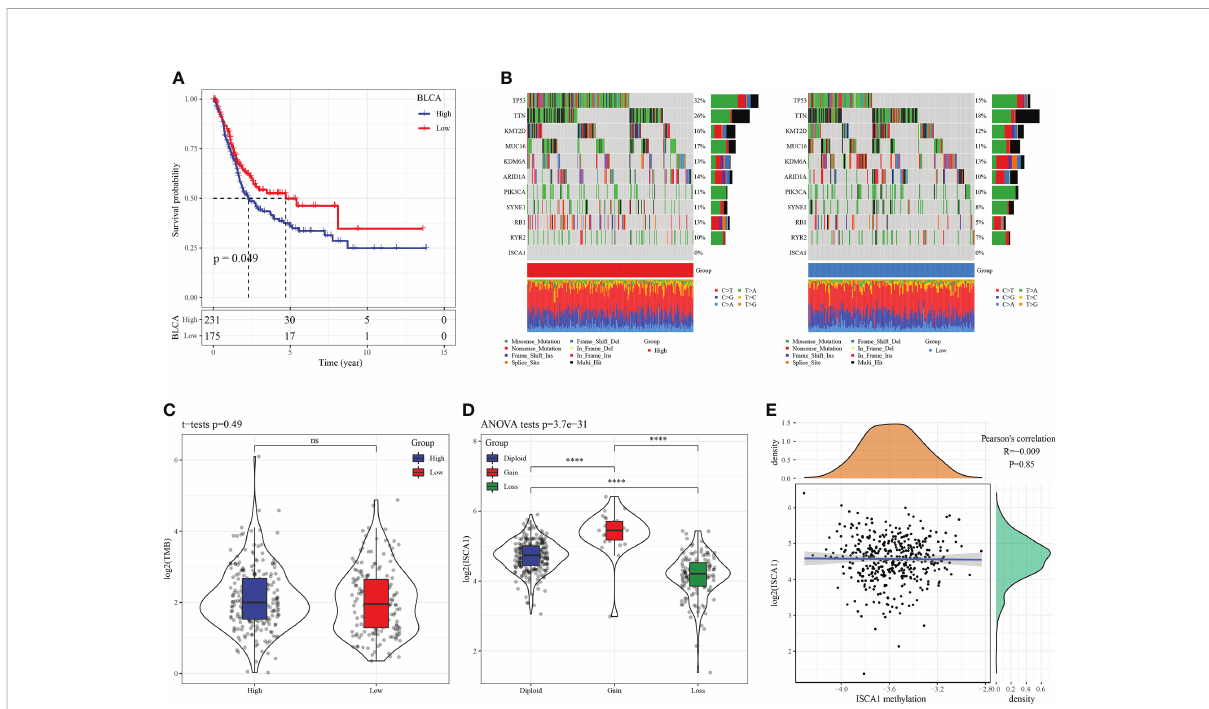
FIGURE 3 SNV, CNV, and methylation analysis in BLCA. (A) : In BLCA, the KM curve showed that patients in high ISCA1 group had worse survival outcome compare to low ISCA1 group, both of which were borderline signi fi cant; (B) : The mutation distribution of the top 10 genes with the highest frequency of mutations in the high ISCA1 expression group and low ISCA1 expression group; (C) : The distribution of TMB in high ISCA1 expression groups and low ISCA1 expression group was compared; (D) : The gene expression difference of ISCA1 in ISCA1 gene ampli fi cation group; (E) : Correlation analysis between gene ISCA1 expression and methylation (**** represents p<0.0001, ns represents p > 0.05).